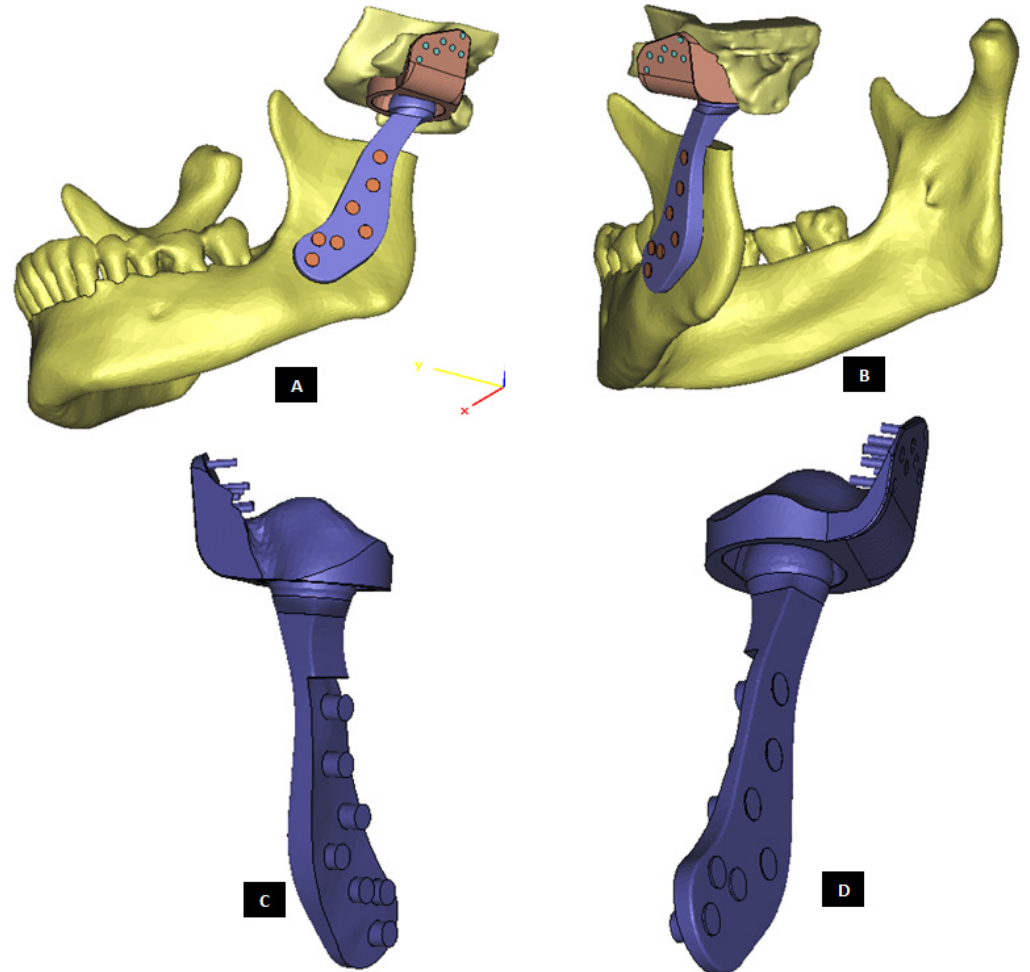
Figure 24. A patient-specific total TMJ prosthesis with medial notches in fossa and condylar com- ponents. ( A ) Shows anterior–lateral view of the ‘notched implants’ with screw holes. Fossa prosthe- sis has two medial notches to be fit into host bone ( B , C ). The articular surface of fossa implant has medio–lateral openings, and is designed to allow optimal anterior and medial translation along with rotation of the prosthetic condylar head along the medio–lateral axis.